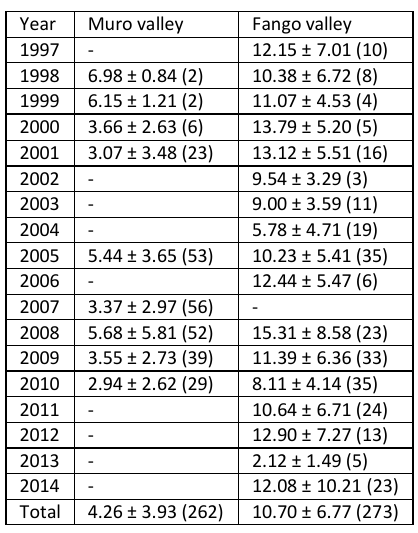
Table 1. Yearly fluctuations in the number (mean ± SD) of Protocalliphora larvae per blue tit nestling on Corsica from 1997 to 2014. Sample sizes (broods) are in parentheses.